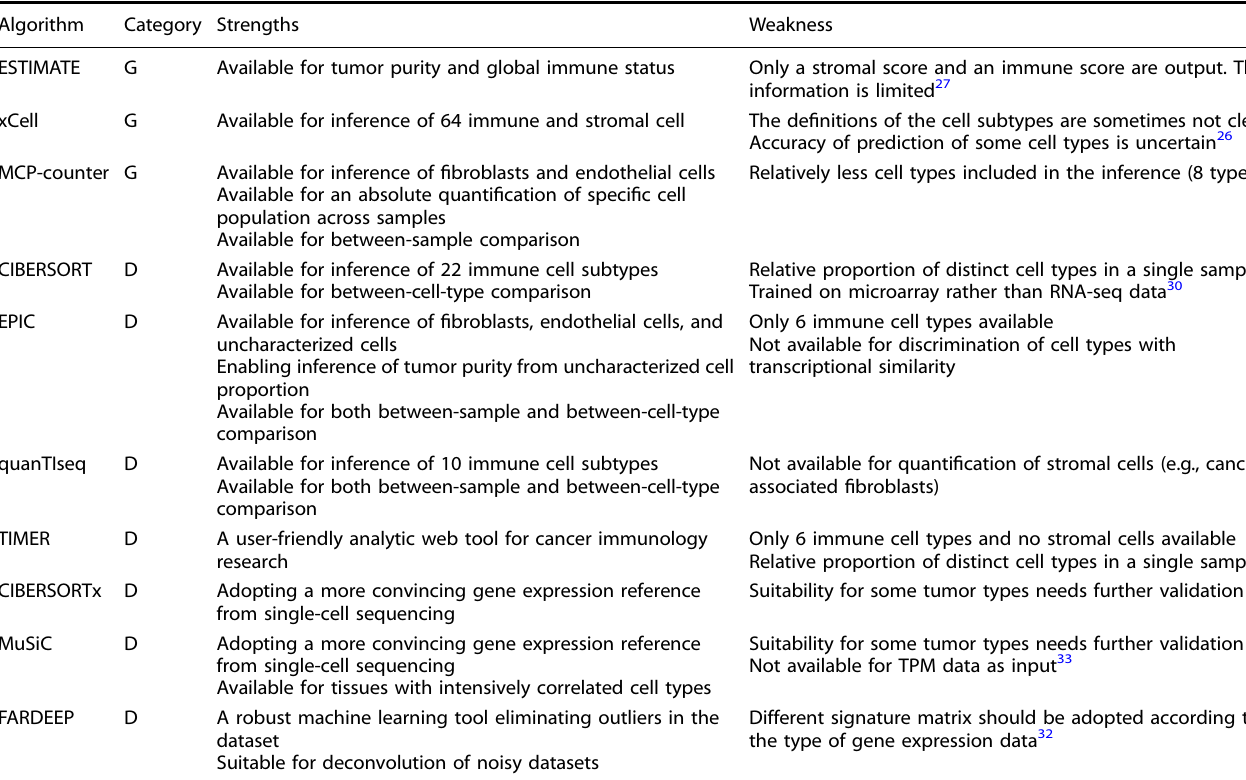
Table 2. Strengths and weaknesses of immune cells quanti fi cation algorithms Algorithm Category Strengths Weakness